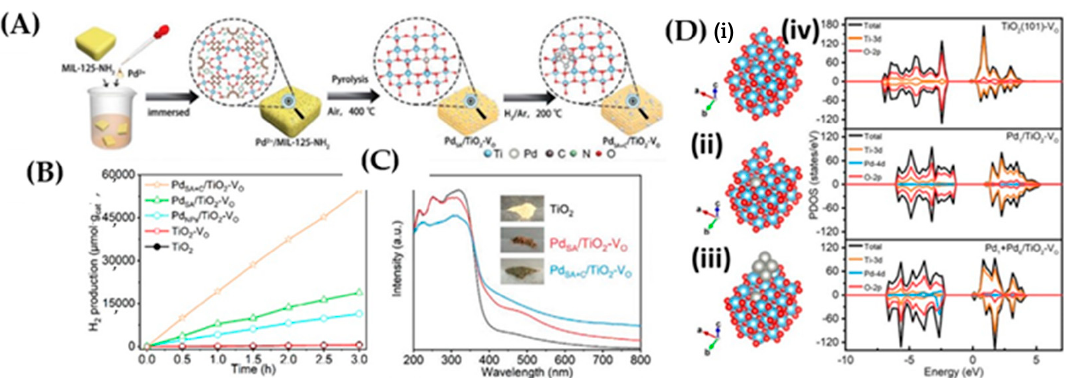
Figure 19. ( A ) Schematic representation of synthesis of Pd SA /TiO 2 -V O and Pd SA+C /TiO 2 -V O ; ( B ) Pho- tocatalytic H 2 production from MeOH aqueous solutions (20 vol%) where Pd SA+C /TiO 2 -V O exhibits the highest H 2 production rate; ( C ) UV-Vis DRS spectra and the photographs of the samples (inset); ( D ) Optimized structures of ( i ) TiO 2 (101)-V O , ( ii ) Pd SA /TiO 2 -V O , ( iii ) Pd SA+C /TiO 2 -V O and ( iv ) the corresponding PDOS diagrams. Adapted from [106] with permission.